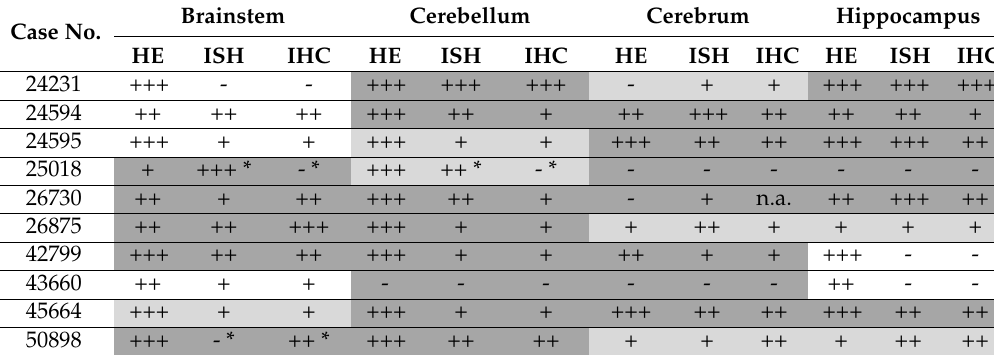
Table 2. Detection of the BoAstV CH13/NeuroS1 by in situ hybridization (ISH) and immunohistochemistry (IHC), evaluation of severity of histopathological lesions, and topographical correlation of viral presence to histopathological